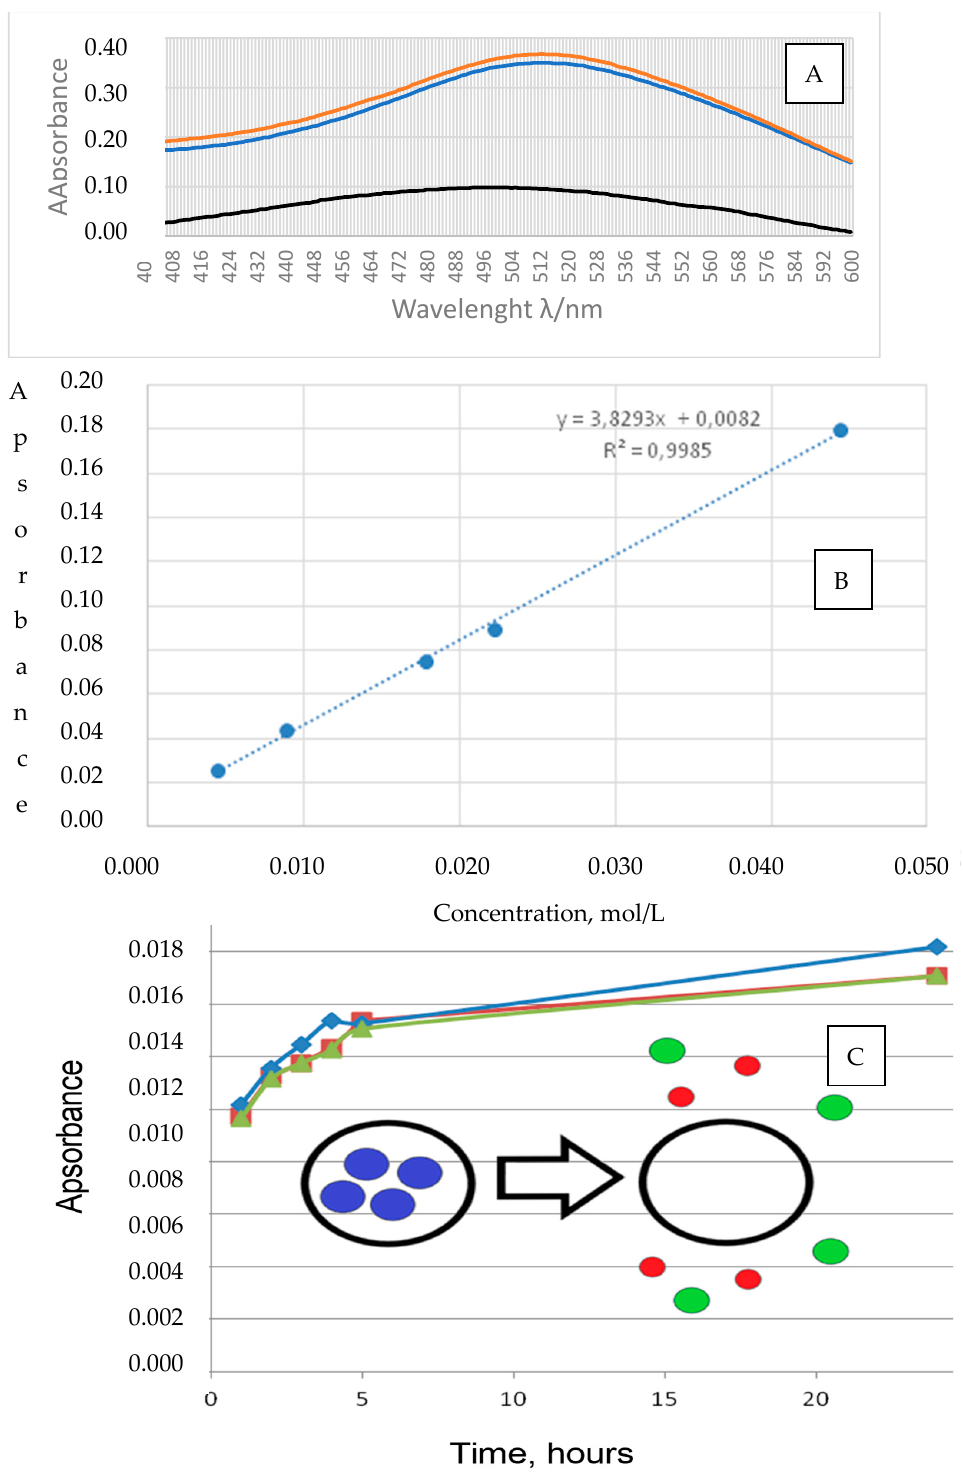
Figure 5. ( A ) UV-VIS curves obtained during measurements (black—silver from microcapsules; blue—standard reference solution with silver ions; and orange—mixture of silver from microcapsules and standard solution, spike solution); ( B ) calibration diagram of silver ion obtained by UV-VIS spectrometry; and ( C ) graphic representation of the silver release over 25 h from microcapsules (blue—450 μ m microcapsules without chitosan, red—120 μ m microcapsules without chitosan, green 120 μ m microcapsules with chitosan). As can be seen in details, the release starts in the first 4 h and then it reaches a meta-stabile phase.